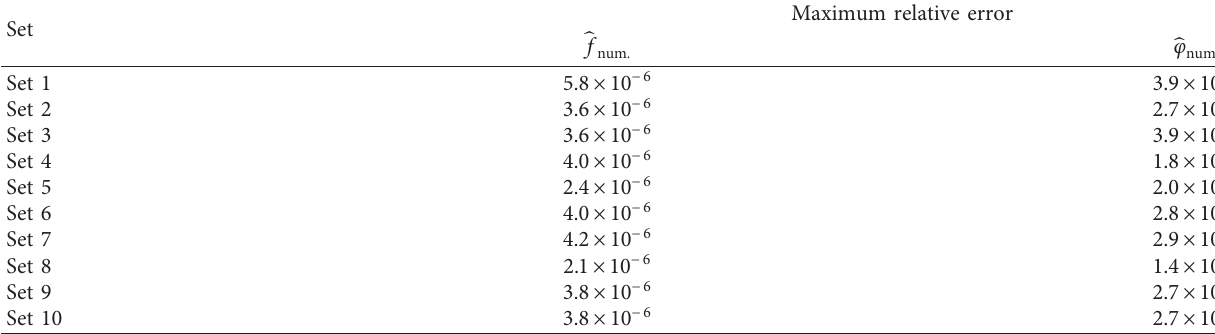
and 􏽢 φ with Δ τ � 0 . 01and Δ v � 0 . 01. num . num .